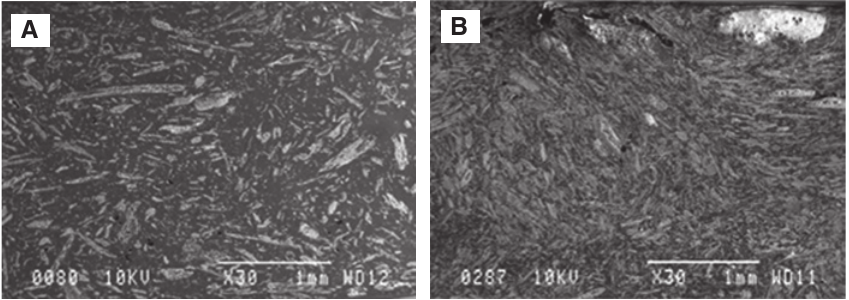
Figure 12 SEM photos of PP triticale composites: (A) 20% and (B) 50% triticale with coupling